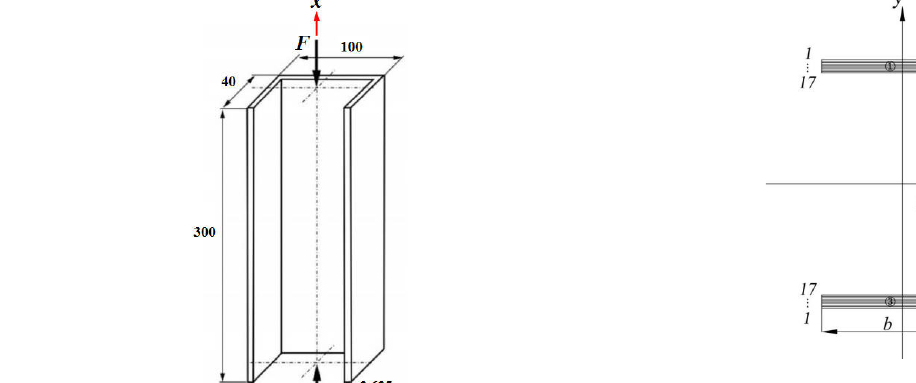
Figure 24: Calculation diagram of the cross section of a single- channel compression